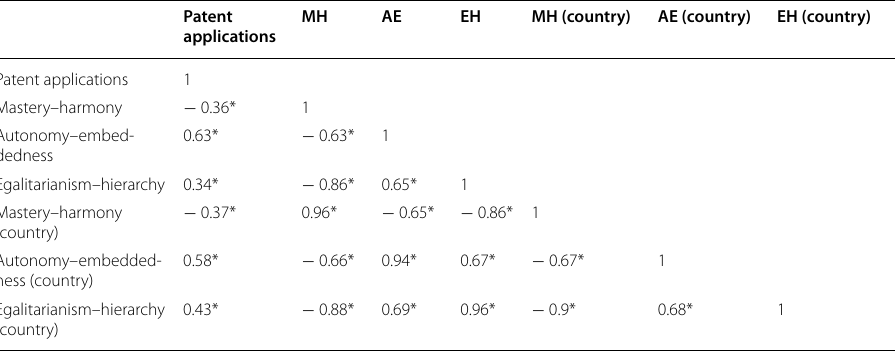
Significant at * p